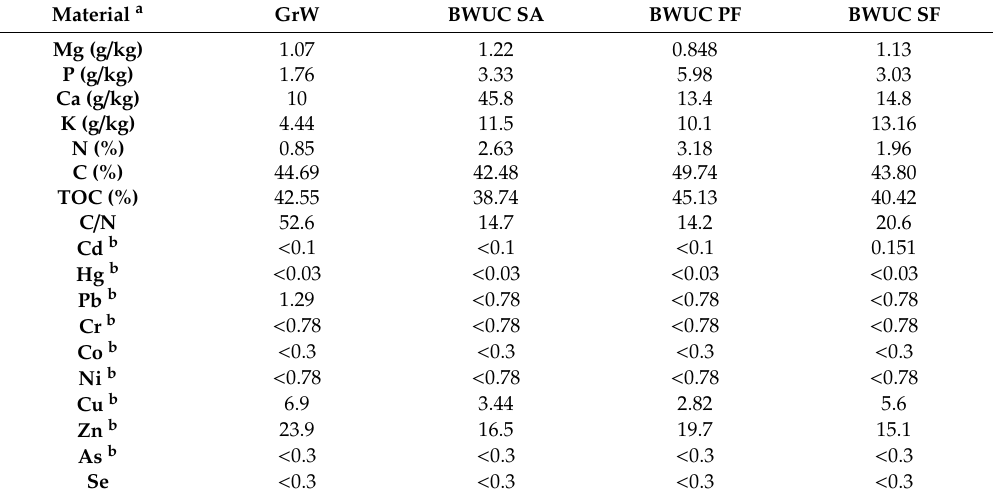
Table 2. Nutrient elements and heavy metals present in the samples of garden waste used as a bulking agent and organic waste from di ff erent UDC centers.